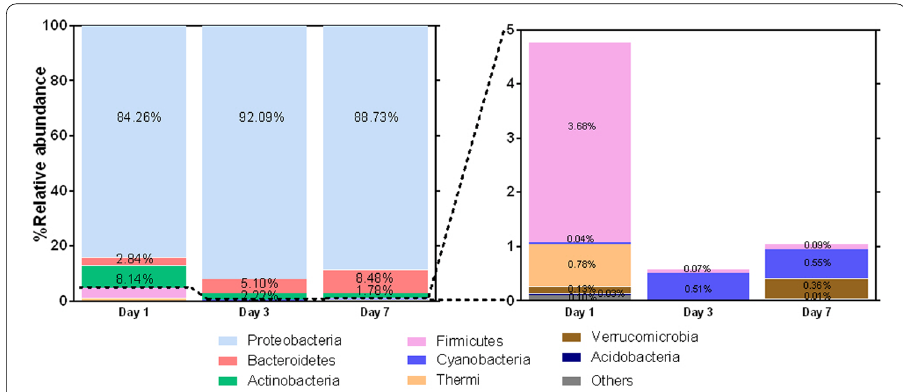
Fig. 3 Overall summary of dynamic bacterial community profiles in COVID‑19 patients on day 1, 3, and 7. Proteobacteria were observed to be the dominant bacterial phyla followed by Bacteroidetes, Actinobacteria and Firmicutes